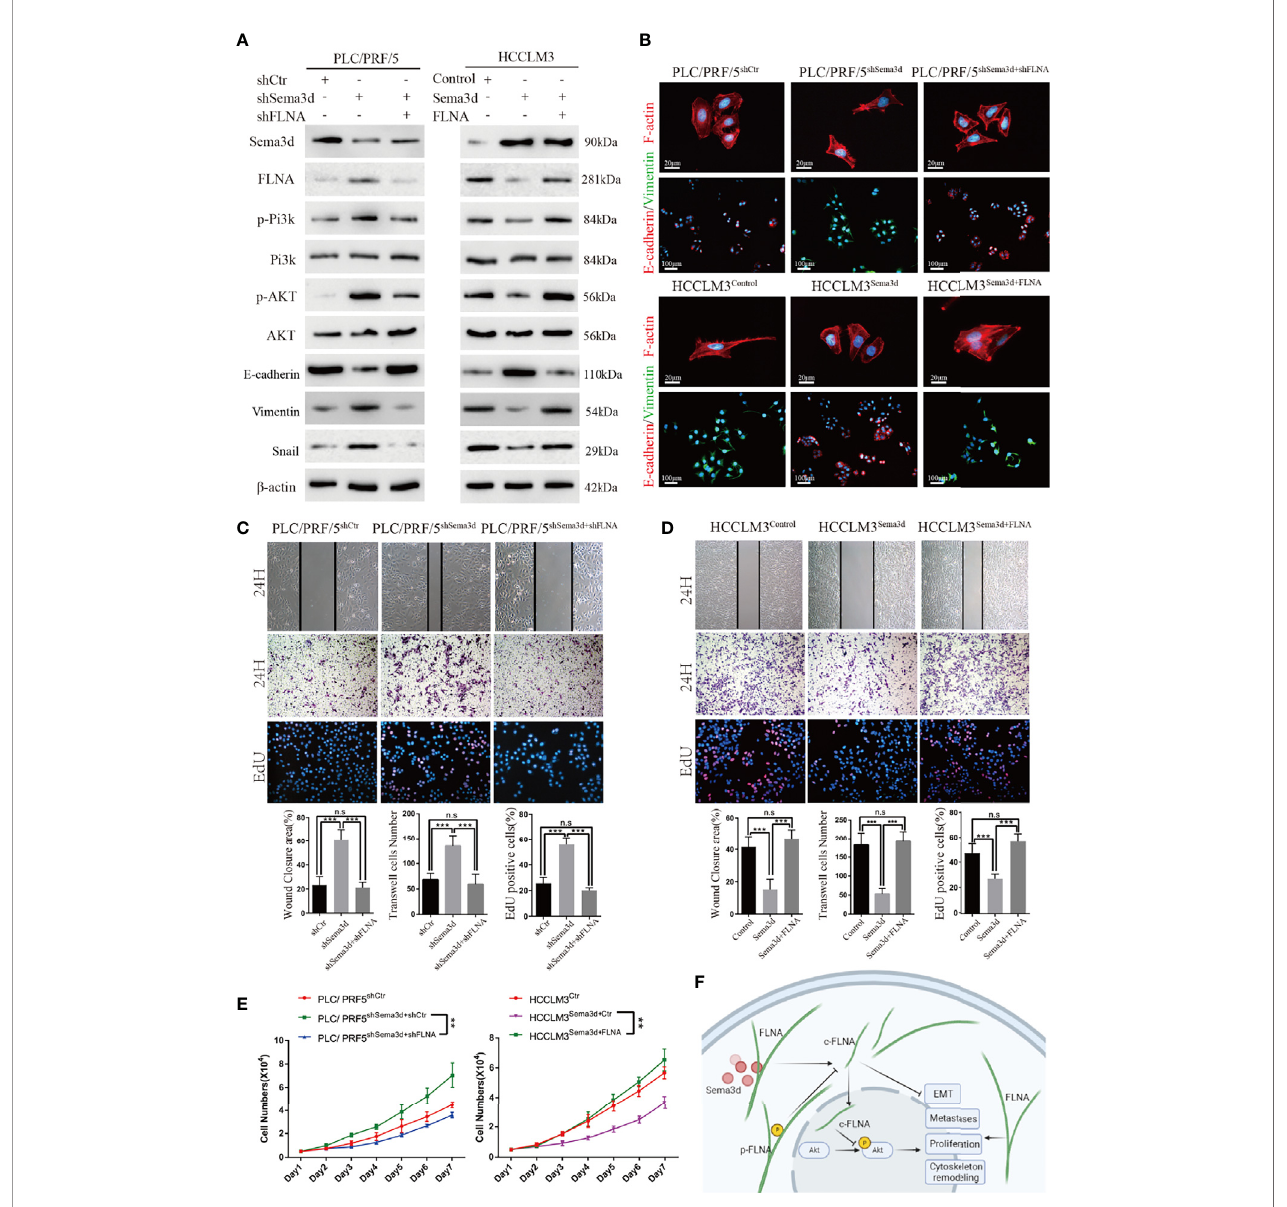
FIGURE 7 | Sema3d suppressed Pi3k/AKT signaling and restrained HCC proliferation, metastasis, and EMT through FLNA. (A) Protein expression level was analyzed by Western blot and showed that Sema3d regulated the phosphorylation level of Pi3k and AKT and expression of EMT markers through FLNA. (B) F-actin and EMT marker proteins in Seme3d- and FLNA-interfered HCC cells were detected by IF. (C) Wound healing, Transwell invasion, and EdU staining assays detected the migration, invasion, and proliferation of HCCLM3 Sema3d ectopic expression of FLNA. (D) Wound healing, Transwell invasion, and EdU staining assays detected the migration, invasion, and proliferation of PLC/PRF/5 shSema3d knockdown FLNA. (E) MTT assay detected a proliferation of HCCLM3 Sema3d ectopic expression of FLNA and PLC/PRF/5 shSema3d interference of FLNA compared with the corresponding control cells. (F) Sema3d restrained hepatocellular carcinoma proliferation, metastases, EMT, and cytoskeleton remodeling through inactivating Pi3k/Akt via interaction with FLNA. ** p < 0.01; *** p < 0.001. n.s, no signi fi